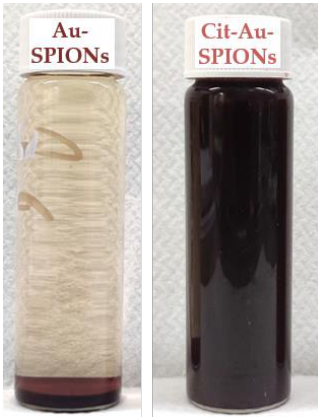
◦ C. Molecules 2020 , 25 , x FOR PEER REVIEW